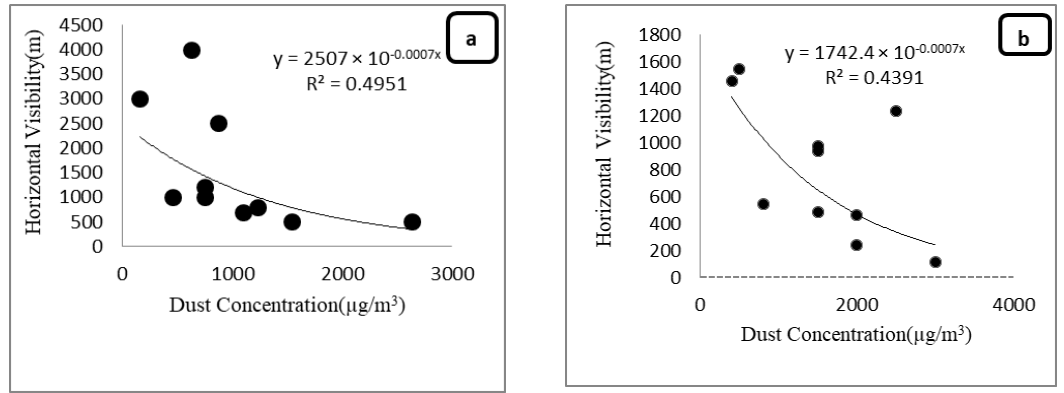
Figure 14. Correlation of Simulated Surface Dust Concentration Using GOCART Scheme with Horizontal visibility of Synoptic Stations in Storms 14 February 2018 (a) and 21 February 2015 (b).